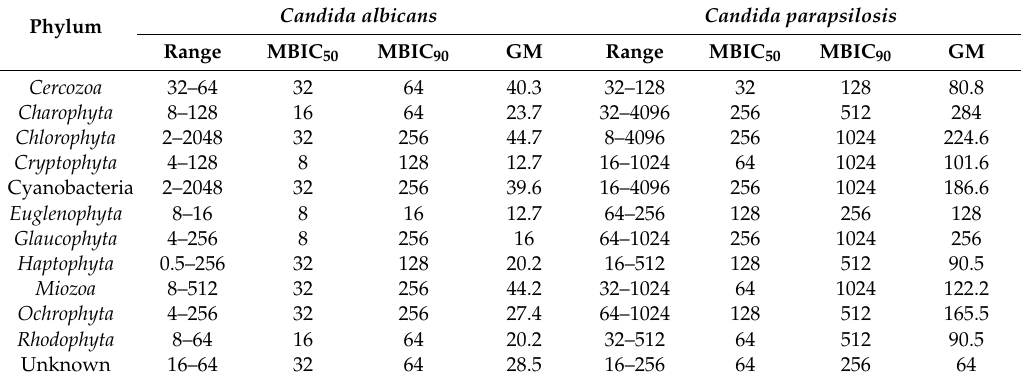
Table 3. Antibiofilm activity against Candida spp. of marine natural products. Range: range of concentrations tested; MBIC 50 : lowest concentration of the test compound that resulted in ≥ 50% inhibition of biofilm formation; MBIC 90 : lowest concentration of the test compound that resulted in ≥ 90% inhibition of biofilm formation; GM: geometric